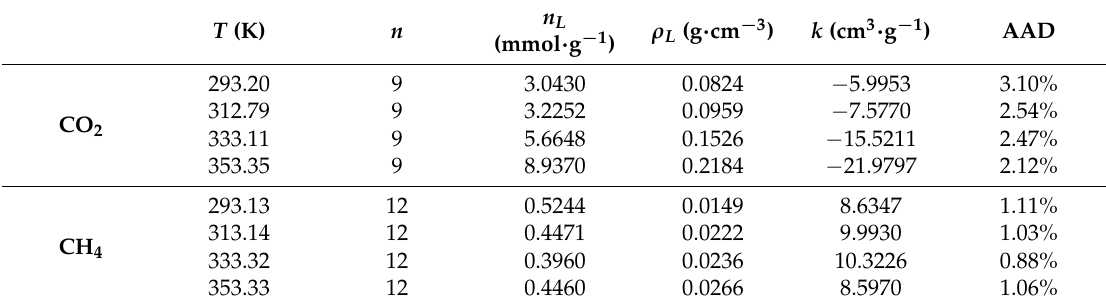
Table 4. Parameters and tolerance analysis of the Langmuir + k model a .